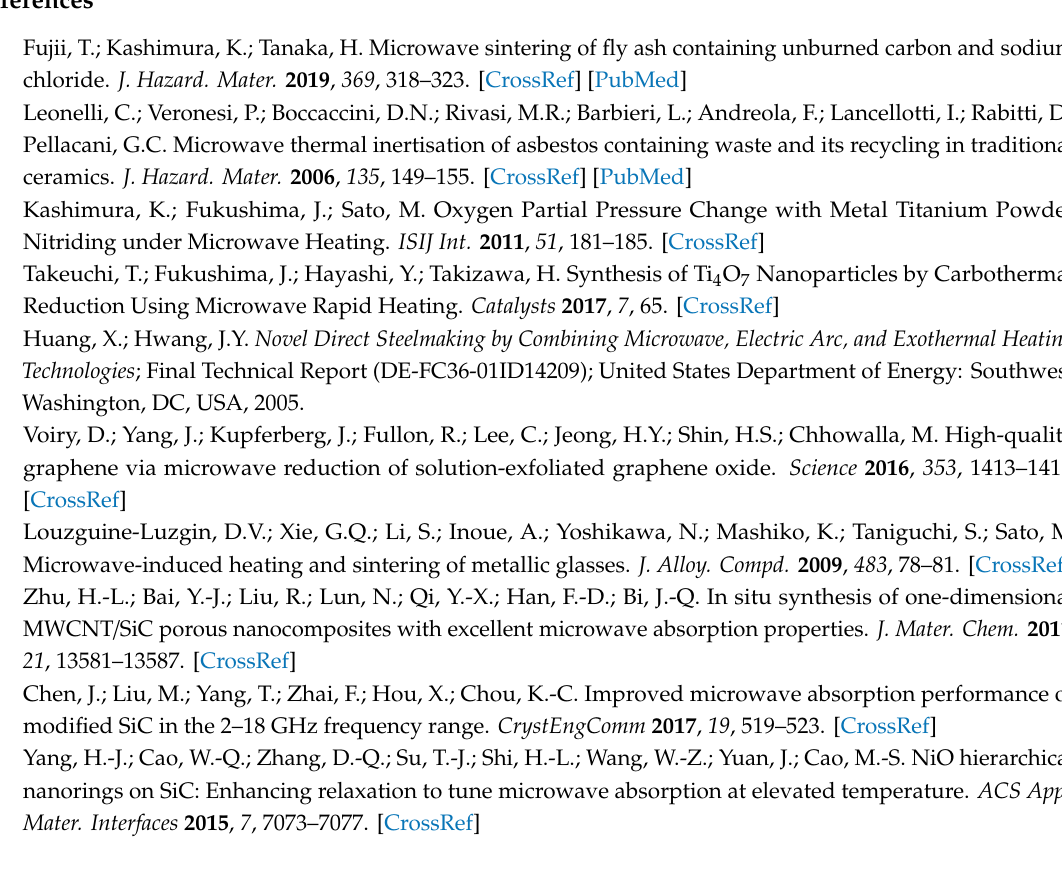
Figure S1. The calculation for the electrical field by scattering field analysis by COMSOL. The electrical field between rods increases as their distance decreases. Figure S2. (a) Si and Ce distribution in SiC fiber-CeO 2 mixture measured by